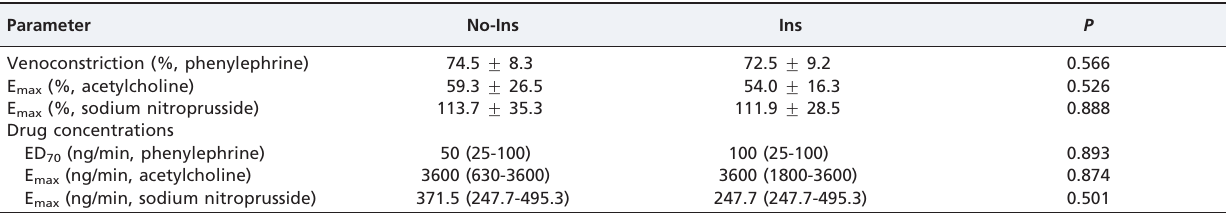
Table 2 - Venous endothelial function by